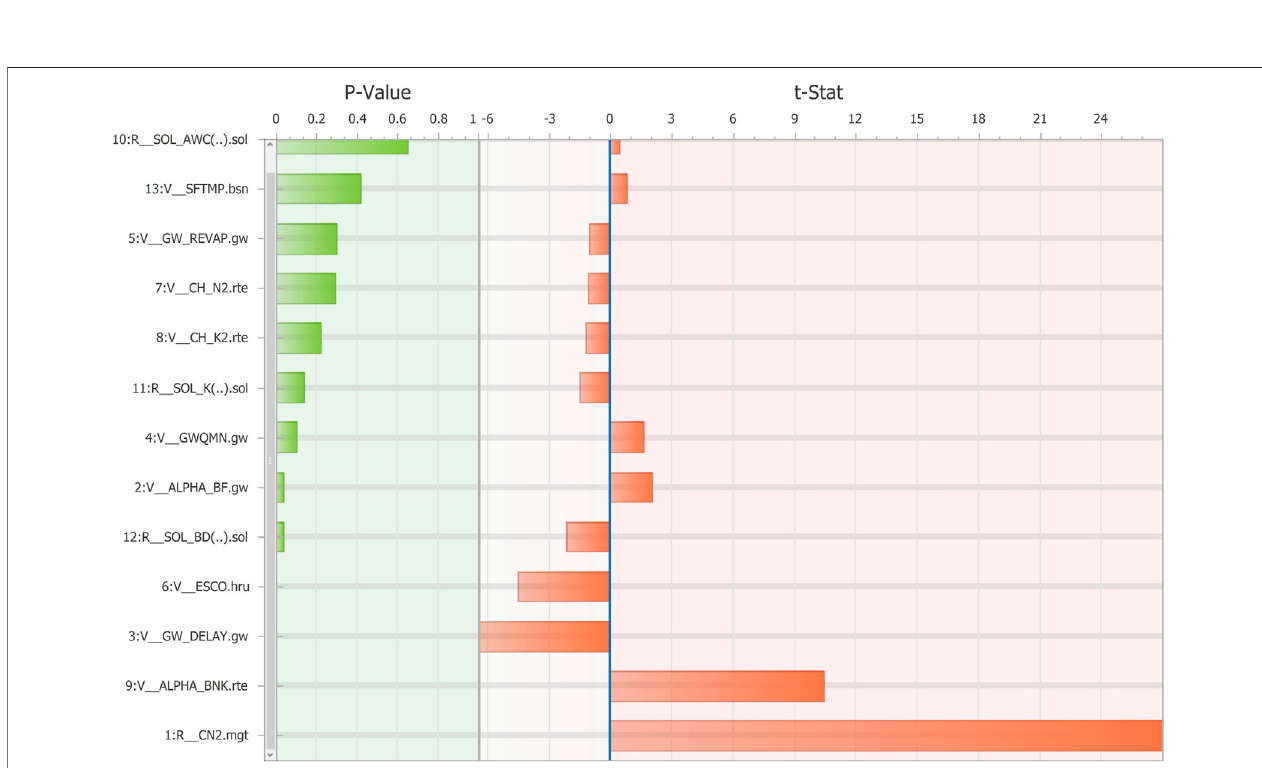
FIGURE 4 | Results of parameter sensitivity